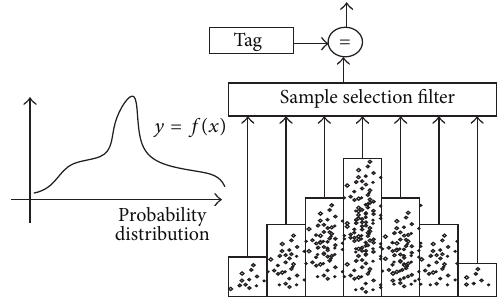
Figure 3: Sample filter based on the probability